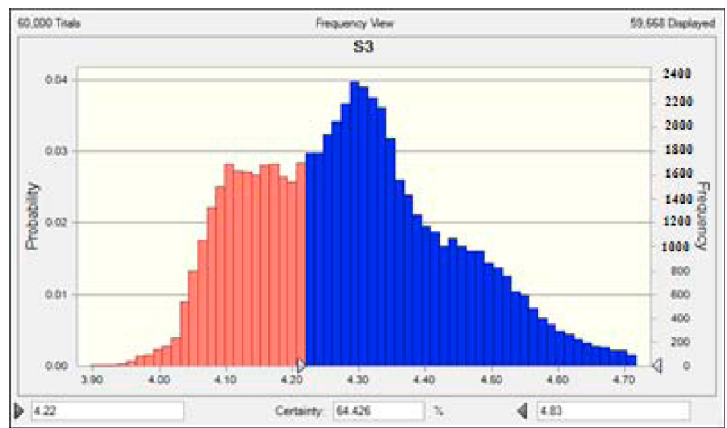
Figure 4. Simulation results of Bosten Lake (S3).